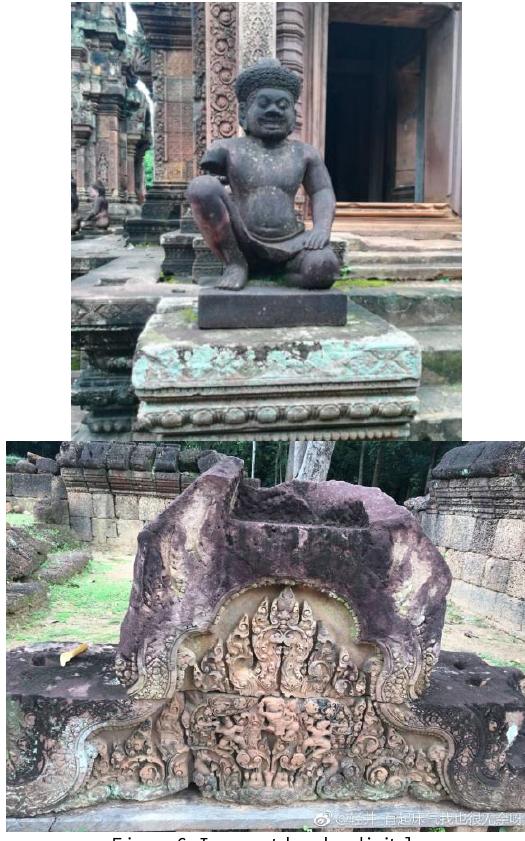
Figure 6. Images taken by digital camera